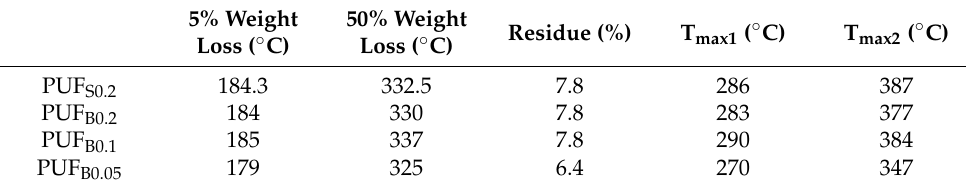
Figure 7. ( a ) TGA and ( b ) DTG curves of the PUF prepared with bismuth triflate and stannous octoate.